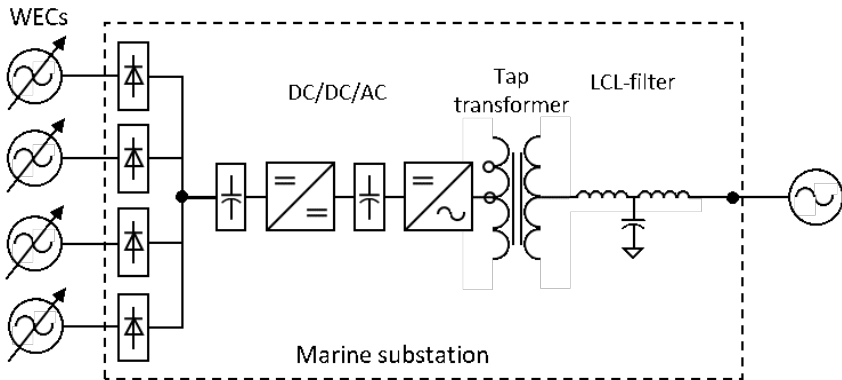
Figure 8. One-line diagram of electrical layout of a wave power farm (WPF) consisting of several of UU’s